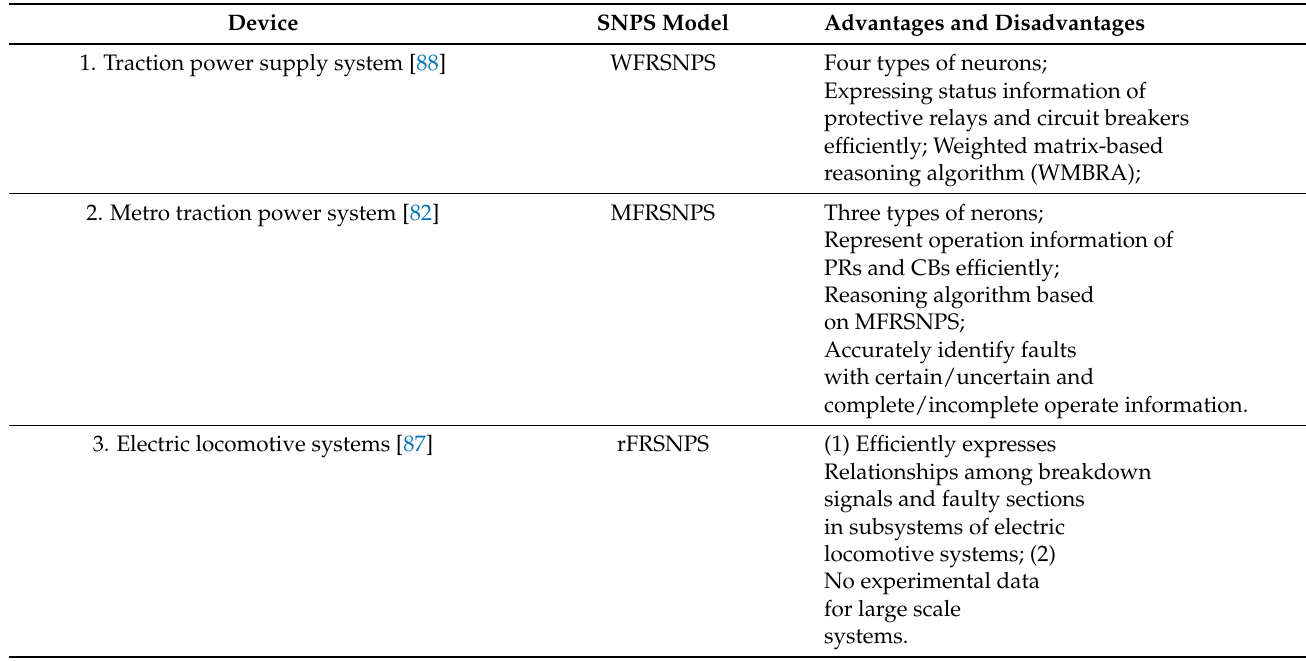
Table 6. Advantages and disadvantages of fault diagnosis models for other types of power systems with spiking neural P systems.